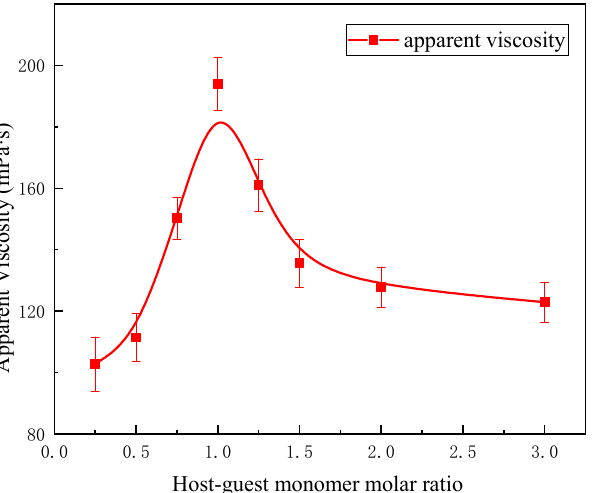
Figure 5. The 0.6 wt.% HGP viscosity at various monomer molar ratios with a shear rate of 170 s − 1 at 25 °C.